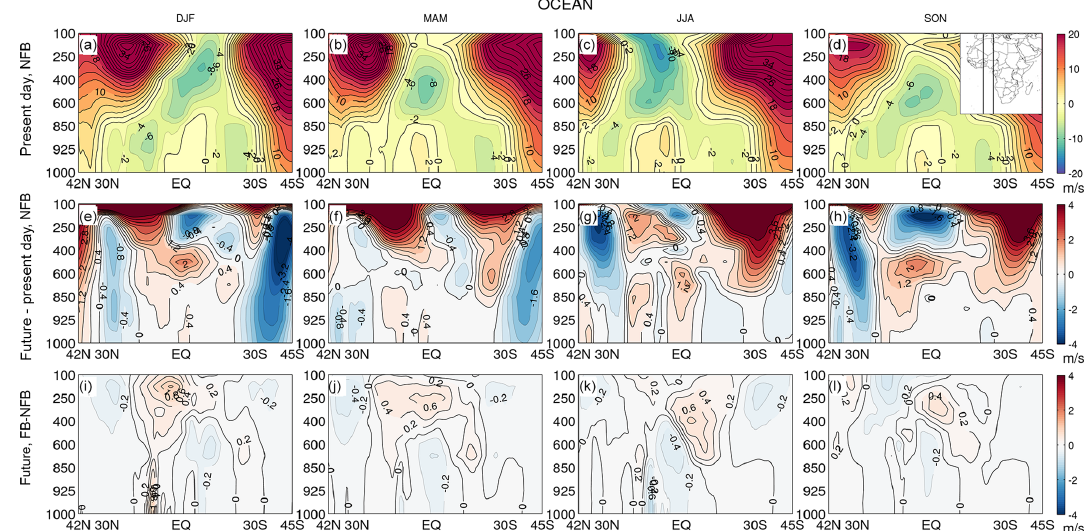
Figure 6. Seasonal mean zonal wind speed in a cross section over adjacent the Atlantic Ocean (0–10 ◦ E; see the inset in d ), for present day (first row), changes in future (future minus present day, second row) and the differences between FB and NFB runs in future (FB minus NFB, third row). Units are in ms − 1 ; positive values represent westerlies and negative values represent easterlies. Present-day and future periods are defined in Sect. 2.2. Contour intervals from top row to bottom row are 2, 0.4 and 0.2ms − 1 ,